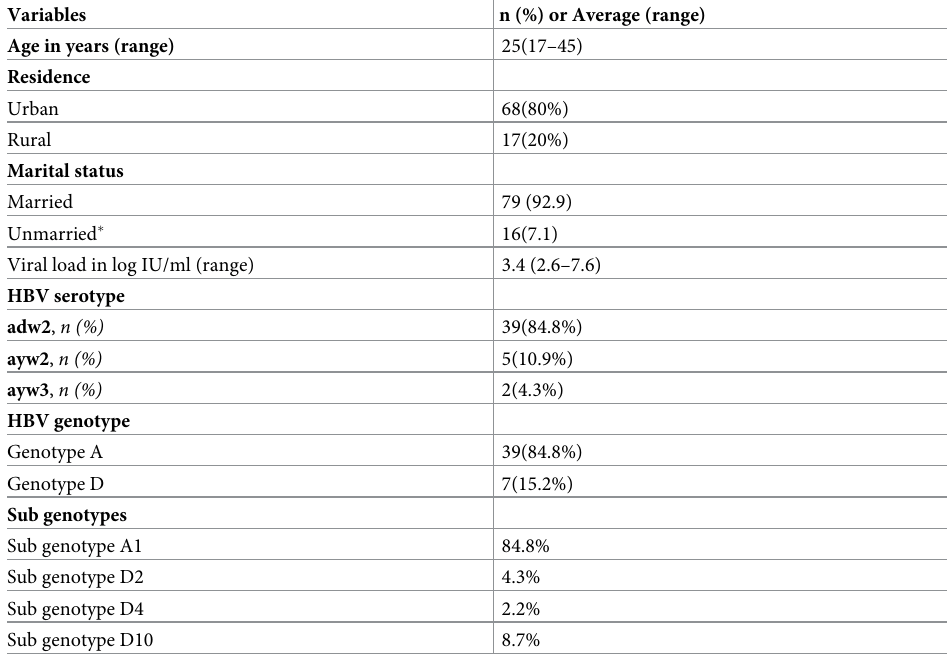
Table 1. Sociodemographic and laboratory profile of HBsAg positive pregnant women.